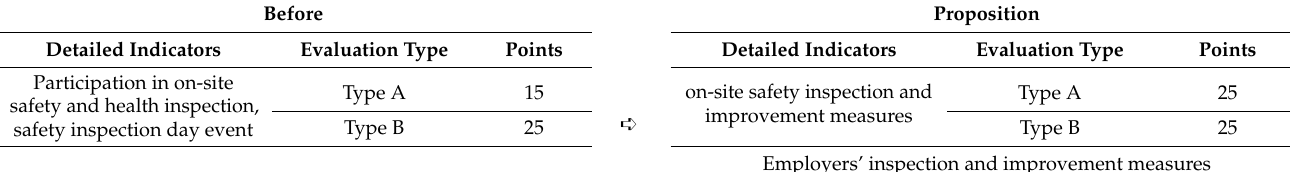
Table 10. Evaluation details for on-site safety inspection and improvement